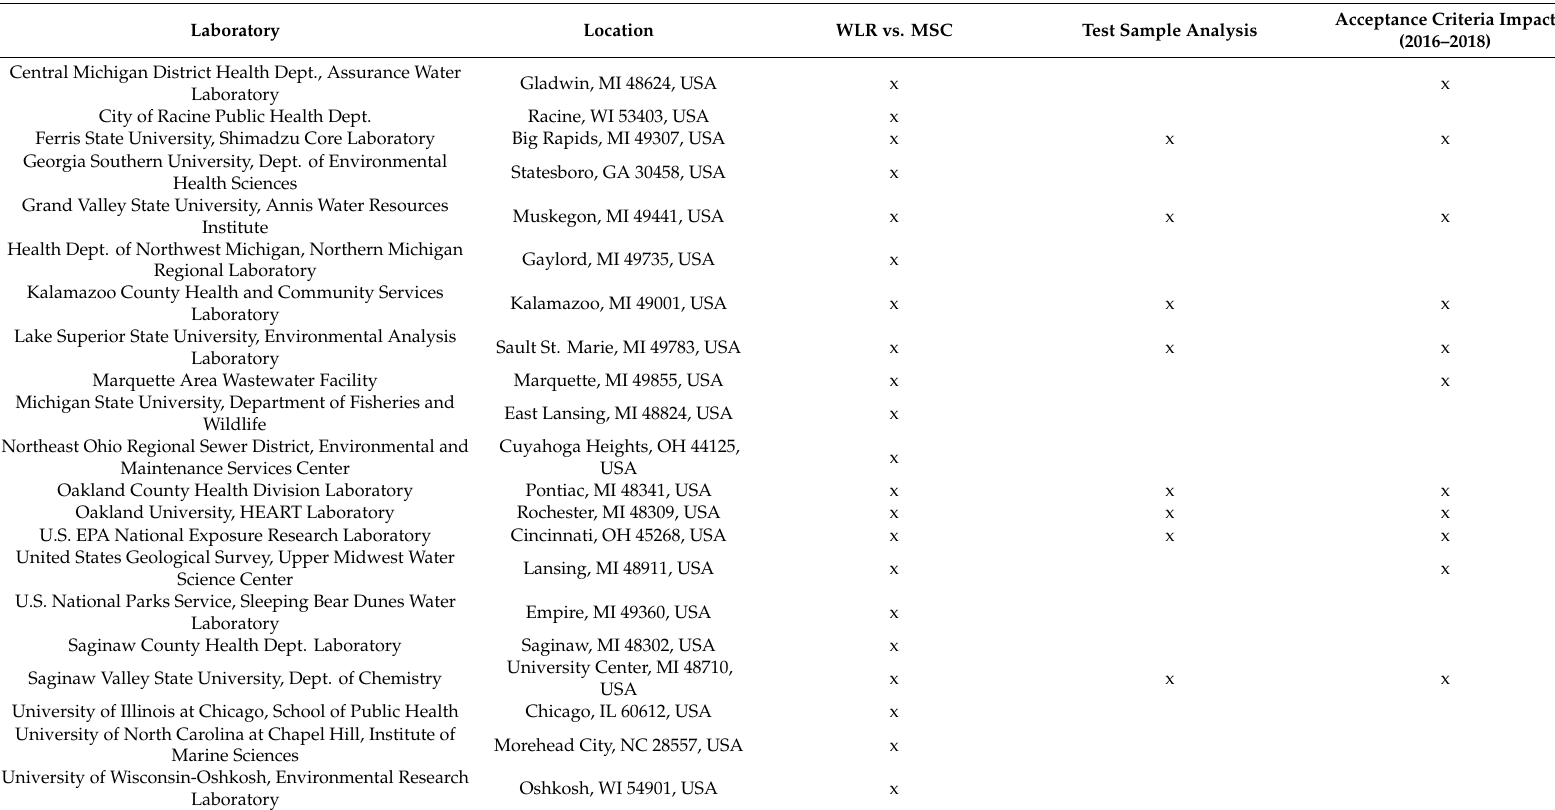
Table 1. Participating labs. List of labs participating in the three assessments conducted in the present study. An ‘x’ indicates that data from the respective lab (row) were used in the respective assessment (column). (WLR = Weighted Linear Regression; MSC = Master Standard